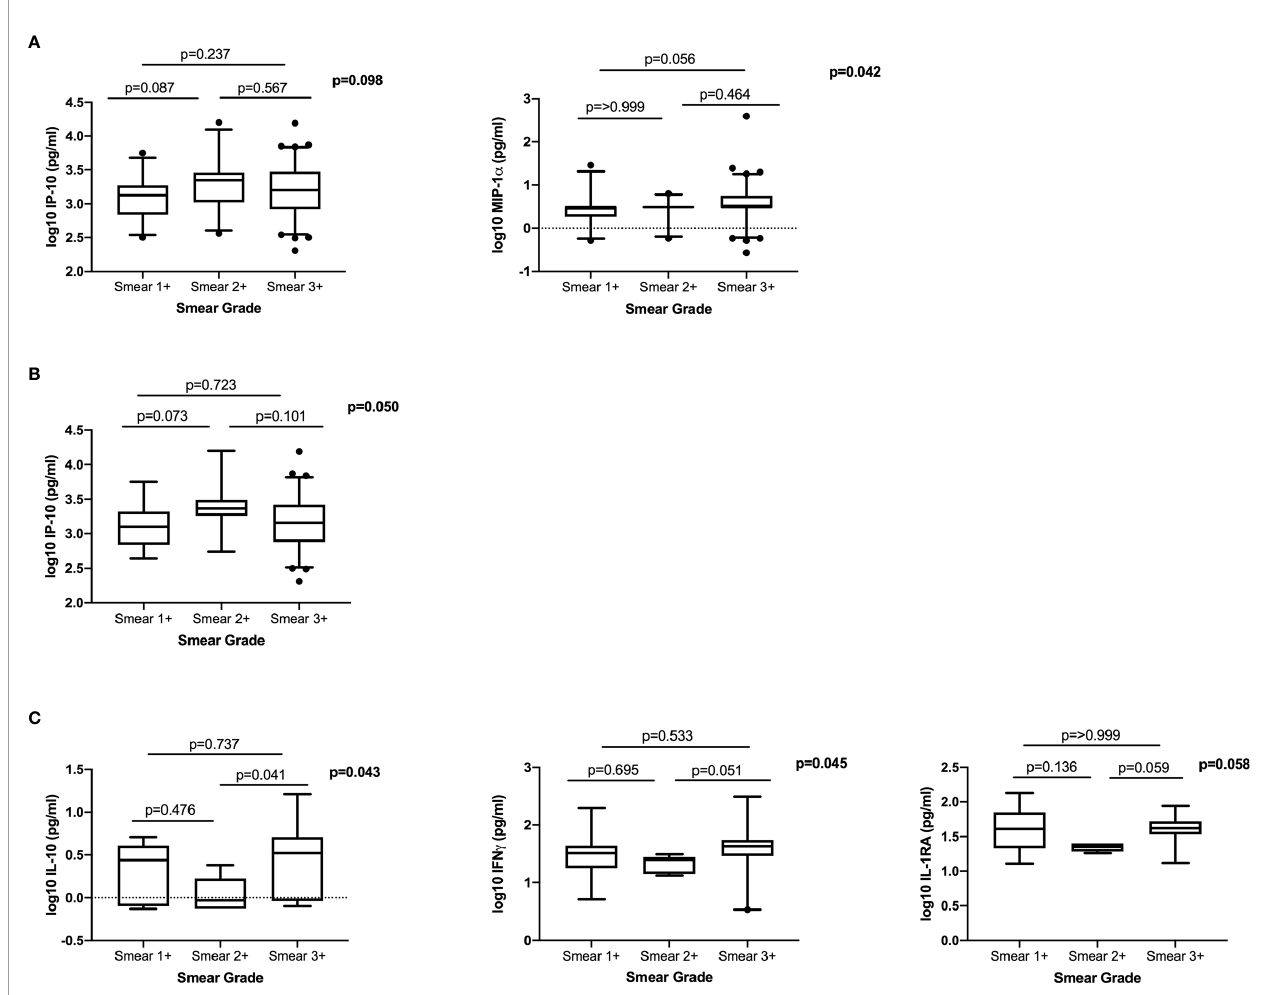
FIGURE 4 | The relationship between plasma cytokines/chemokines and bacterial burden measured by smear grades: (A) Total cohort; (Smear 1+ n= 27, Smear 2+ n=24, Smear 3+ n=81), (B) HIV-infected (Smear 1+ n=16, Smear 2+ n=18, Smear 3+ n=62) and (C) HIV-uninfected (Smear 1+ n=11, Smear 2+ n=6, Smear 3+ n=19). Only cytokines that were signi fi cantly different or trending towards signi fi cance are shown. Based on distribution IP-10 was analysed using a one-way ANOVA with Tukey ’ s multiple comparisons test and MIP-1 a , IFN g , IL-10 and IL-1RA were analysed using non-parametric Kruskal Wallis test with Dunn ’ s multiple comparisons test. Cytokines were plotted on log scale (Log 10), Box and Whiskers (5 –